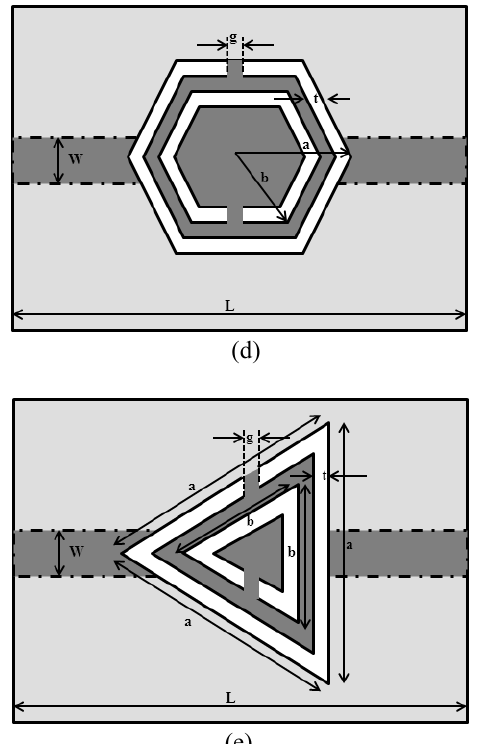
Fig.1 CSRR-DGS geometries with convention DGS: (a) Square DB-DGS (b) Square CSRR-DGS (c) Circular CSRR- DGS (d) Hexagonal CSRR-DGS (e) Triangular CSRR-DGS